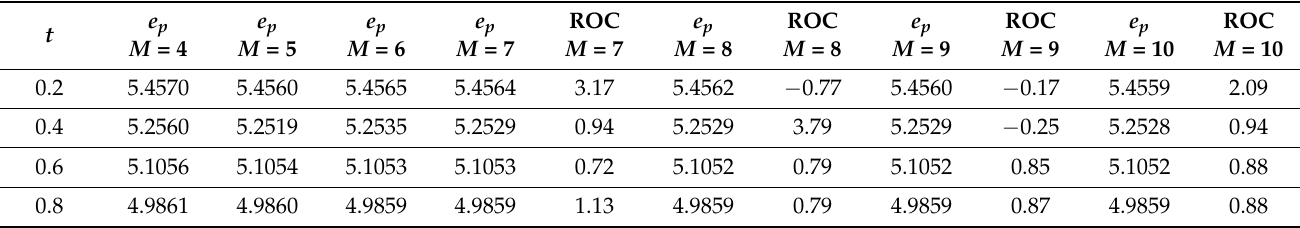
Table 3. The values of e p and rate of convergence (ROC) at different points for k = 2 and various values of M by Bernoulli